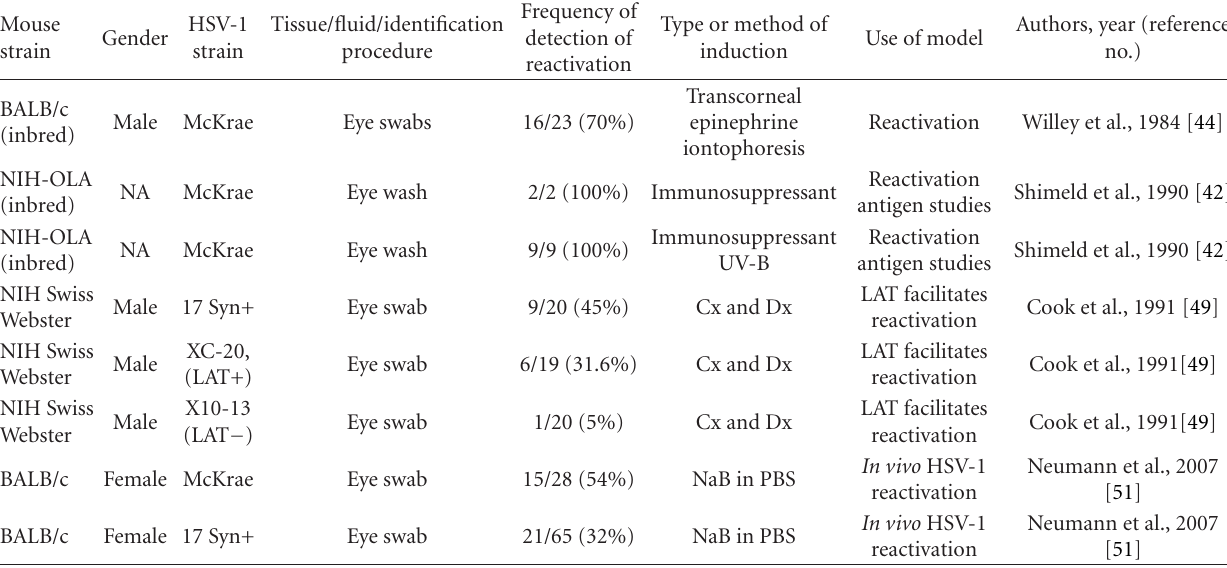
Table 3: Detection of infectious HSV-1 from latent mice following stimulation.